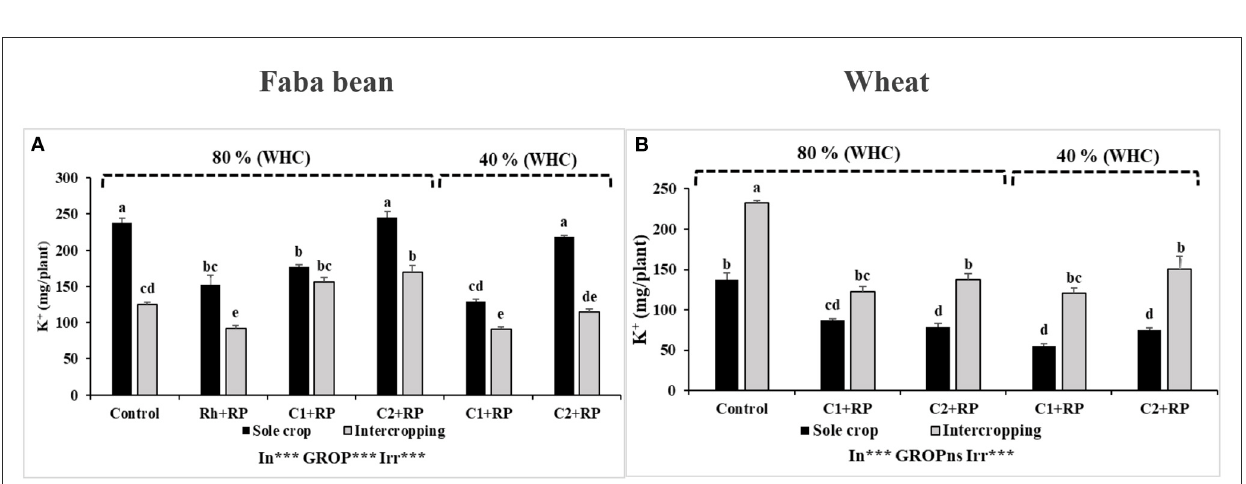
FIGURE10 Faba bean (A) and wheat (B) K contents. Plants were grown as a sole crop or intercropped under water sufficiency and P limitation (80% WHC, RP) vs. combined water deficit and P limitation (40% WHC, RP) and inoculated with two rhizobacterial consortia (C1 and C2) containing rhizobia and two PGPRs. The positive controls were supplemented with 125 µ mol/l of KH 2 PO 4 and 46 mg/l of KNO 3 (control). The negative controls received RP and were inoculated with the rhizobia only (Rh + RP). Each value represents the mean ± standard error (SE) of three replicates (In, inoculation; GROP, type of cropping; Irr, irrigation). Values with different letters are significantly different at 0.05 level of probability by Student-Newman-Keuls. * Represent the significance level of